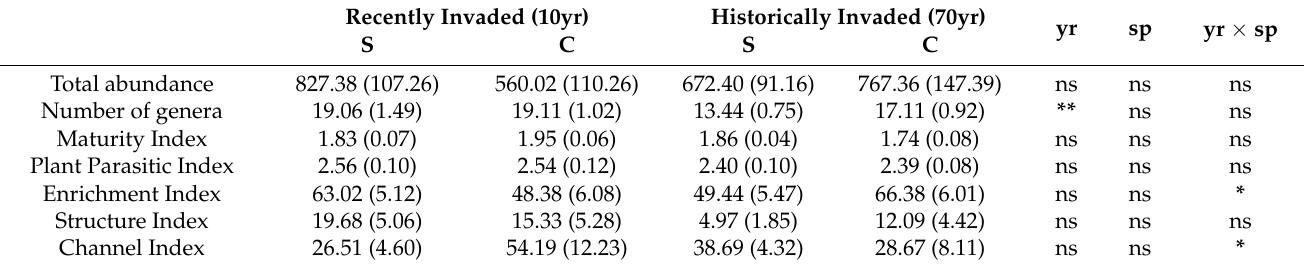
Table 2. Mean values ( ± SE) of total nematode abundance (individuals per 100 g dry soil), number of nematode genera and nematode functional indices in the rhizospheres of the alien Solanum elaeagnifolium (S) and the native Cichorium intybus (C) in recently (10yr) and historically (70yr) invaded sites. PERMANONA results for the effects of factors “year”, “species” and their interaction are